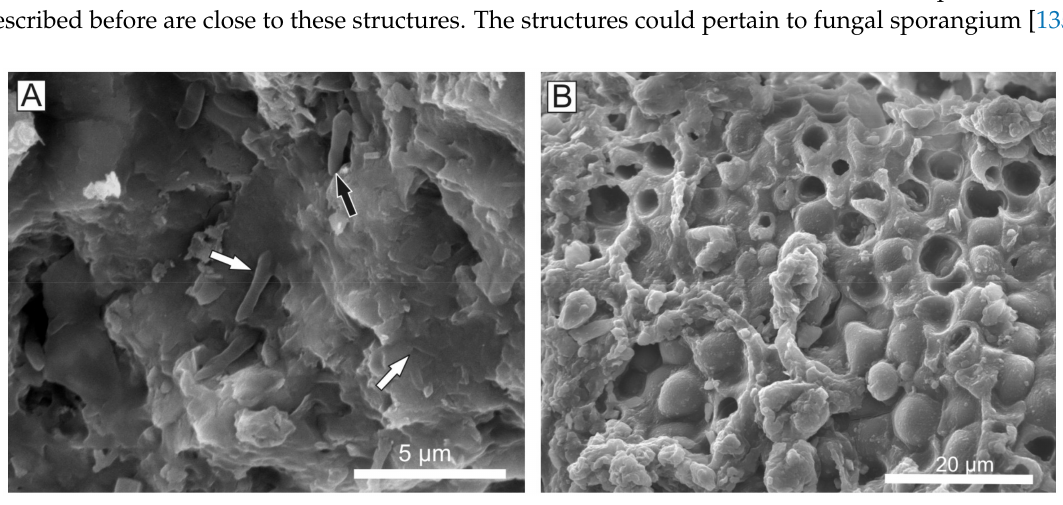
Figure 16. SEM images of microbial structures recorded in the Mn crust of Ras Leona outcrop. ( A ) Bacillus- shaped microbes, generally fused with the Mn minerals (white arrows) but locally well-preserved (black arrow). ( B ) Biofilms with sac-like structures in the surface resembling a fungal